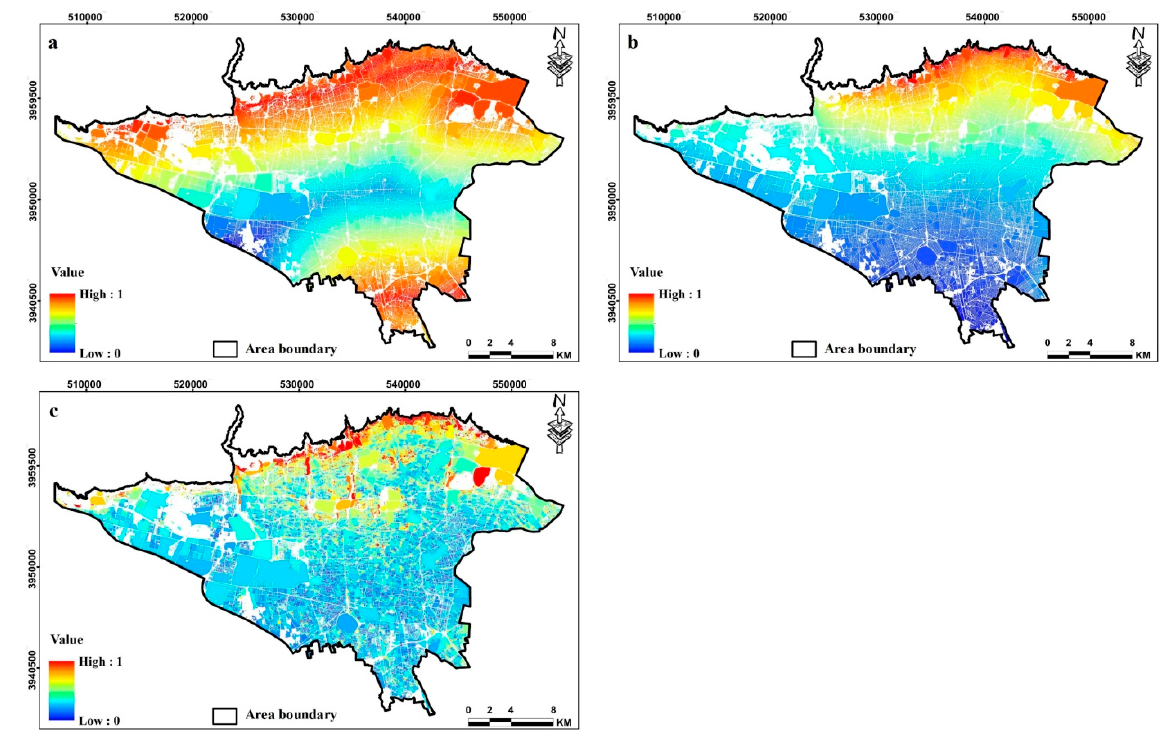
Figure 8. Fuzzification map of exposure criteria: ( a ) average distance from fault; ( b ) average elevation; and ( c ) Average slope.